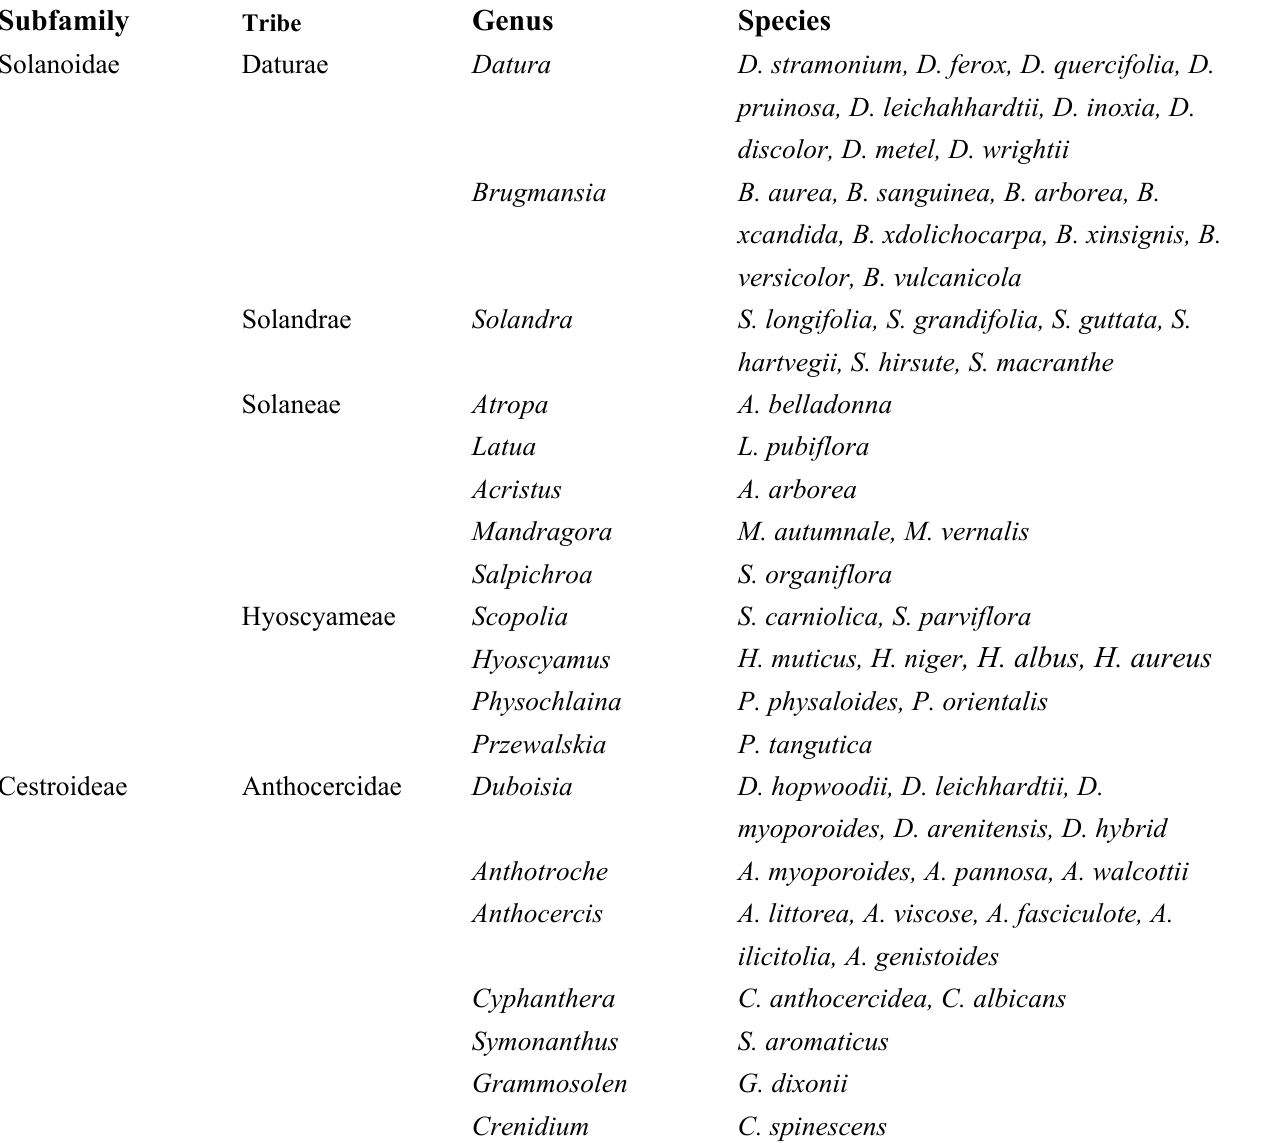
Table 1. Distribution of hyoscyamine and/or scopolamine in the Solanaceae family